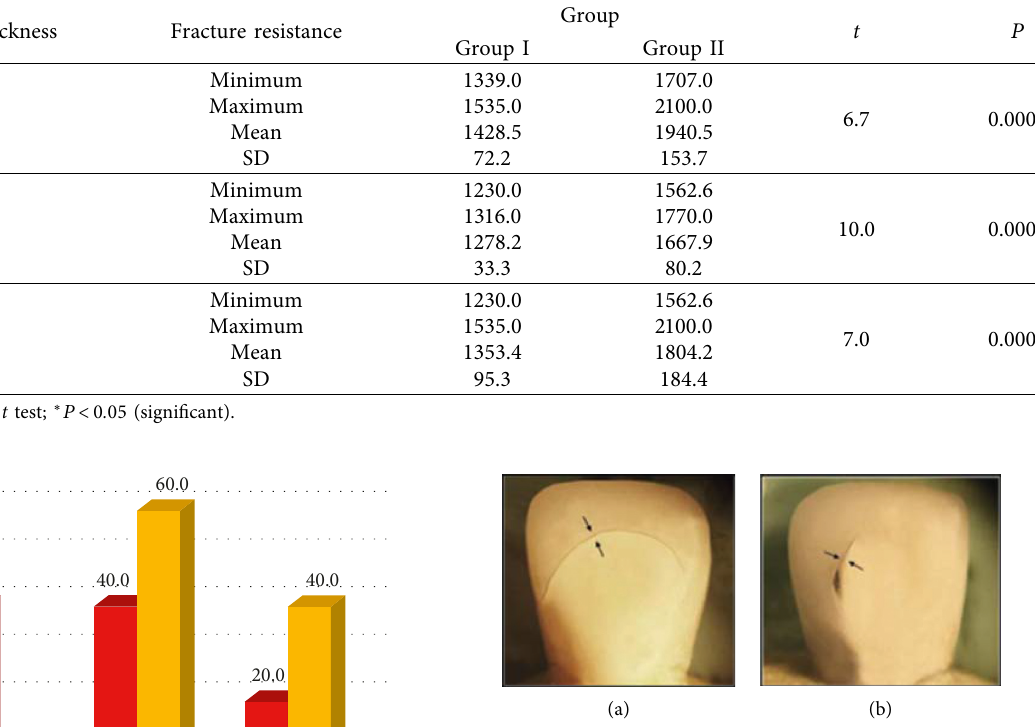
Figure 19: Mode I (visible crack) detected under